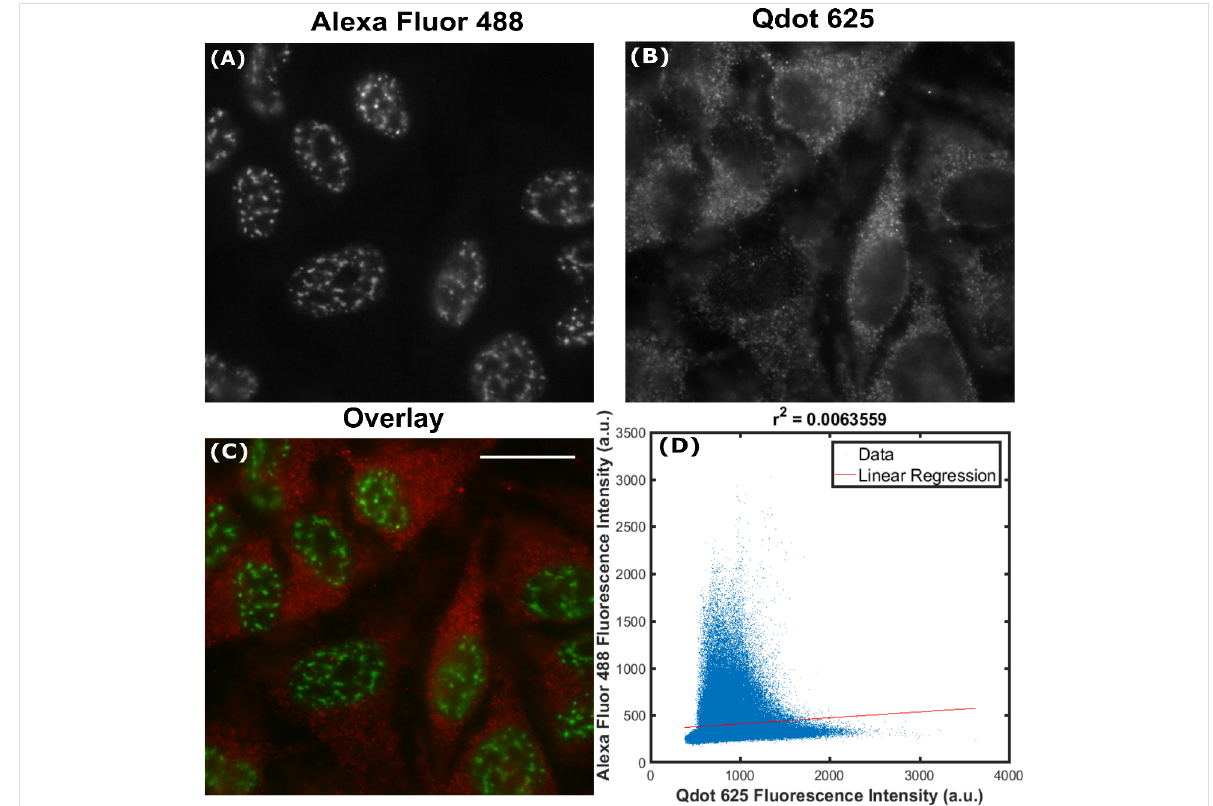
Figure 5: Non-specific labelling of SC35 with Qdots. Fixed HeLa cells were dual labelled with green Alexa Fluor 488 (A) and red Qdot 625 (B) to produce an overlaid wide-field image (C). Scale bar is 20 μ m. As a measure of co-localisation between Alexa Fluor 488 and Qdot 625, fluorescence intensities of the overlaid wide-field image (C) were analysed using a custom-written Matlab code to produce a correlation scatter plot (D). Pearson’s correlation coefficient ( r 2 ) of 0.006 indicates no co-localisation. The average Manders' coefficient of Alexa Fluor 488 overlapping with Qdot 625 (M1) was 0.19 (SD = 0.035, N = 3) and the average Manders’ coefficient of Qdot 625 overlapping with Alexa Fluor 488 (M2) was 0.08 (SD = 0.031, N = 3), as determined using JACoP.